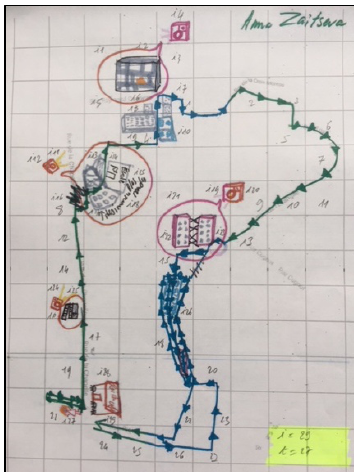
Figure 10. 3 operations were used: 1) Division with a grid of 10 x 15 compartments for each sketch map, 2) Counting of traces or/and icons in each one, 3)